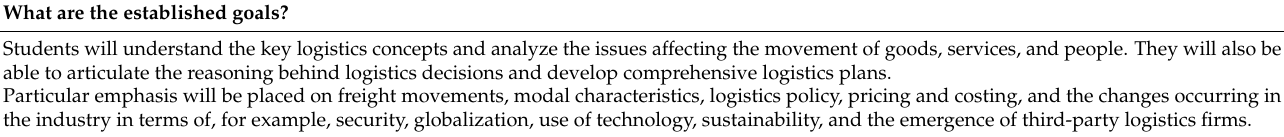
Table 1. Teaching Plan Stage 1—Identify desired